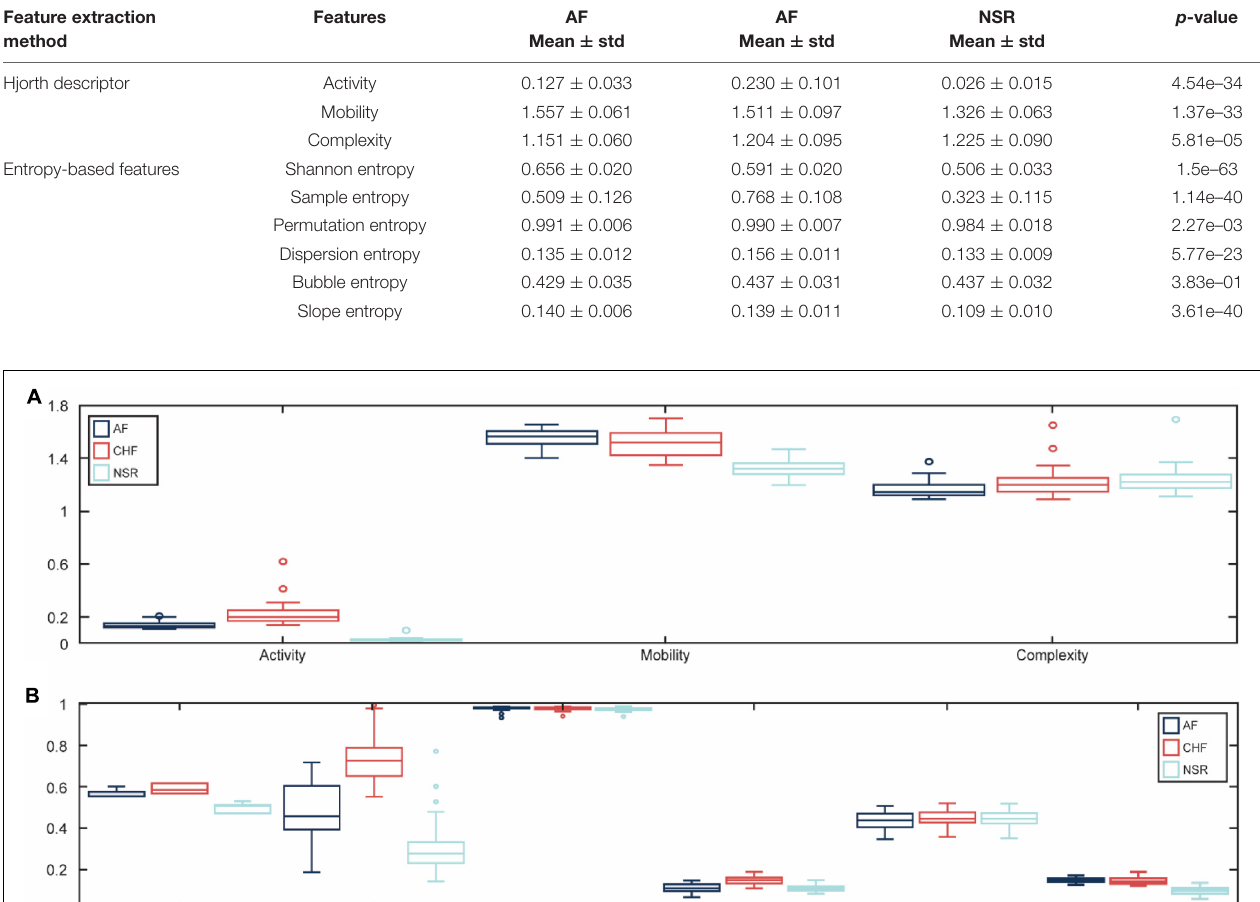
to differentiate AF, CHF, and NSR conditions. As shown